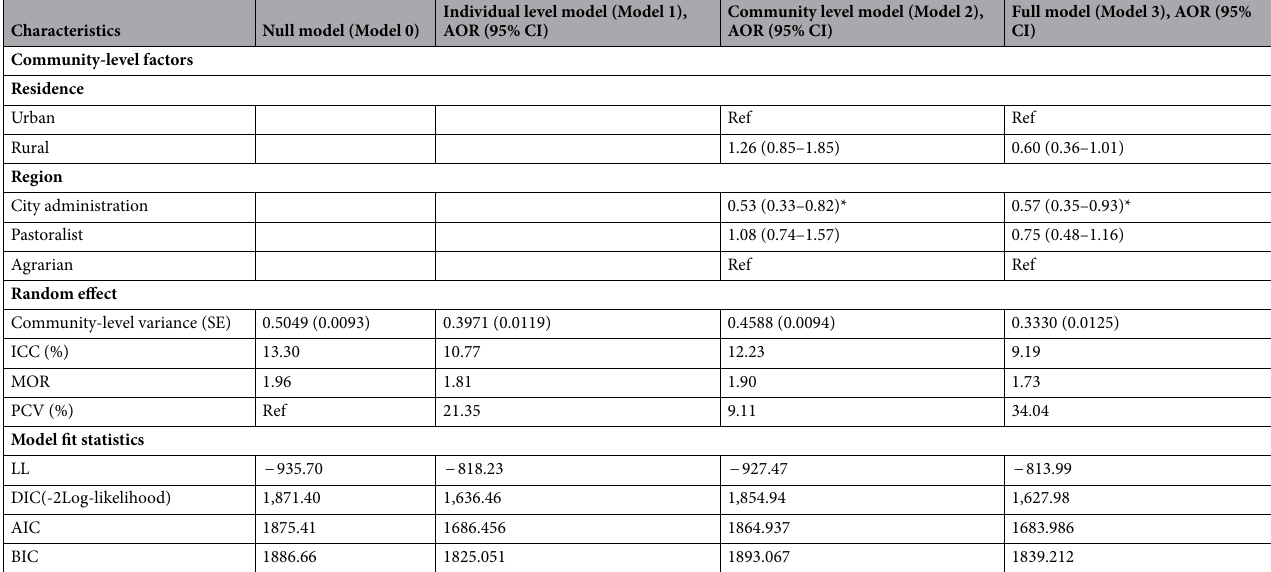
Table 5. Multivariable multilevel logistic regression analysis of factors associated with childhood underweight among children aged 0–23 months in Ethiopia, EMDHS 2019. ** p -value < 0.001; * p -value < 0.05; SE Standard Error; ICC Intra-class Correlation Coefficient; MOR Median Odds Ratio; PCV Proportional Change in Variance; AIC Akaike’s Information Criterion; BIC Bayesian information Criteria; DIC Deviance Information Criterion; LL